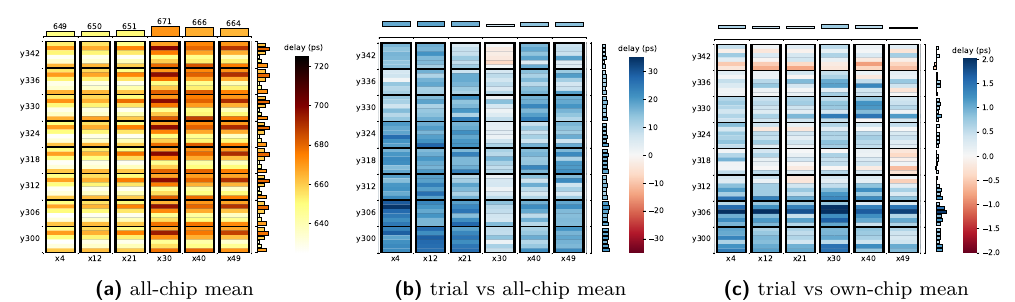
Figure 4: Measured SLL delays collected from EC2 F1 instances. (a) shows mean delays of each SLL across 20 chips. (b) and (c) show how much the delays from Fig. 3b deviate from the values in (a), and from the mean delays of the same chip that produced Fig. 3b. Note that (b) and (c) have different scales.